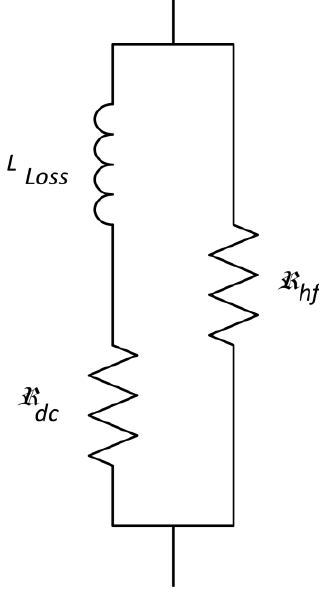
Figure 11: Modified model of leakage